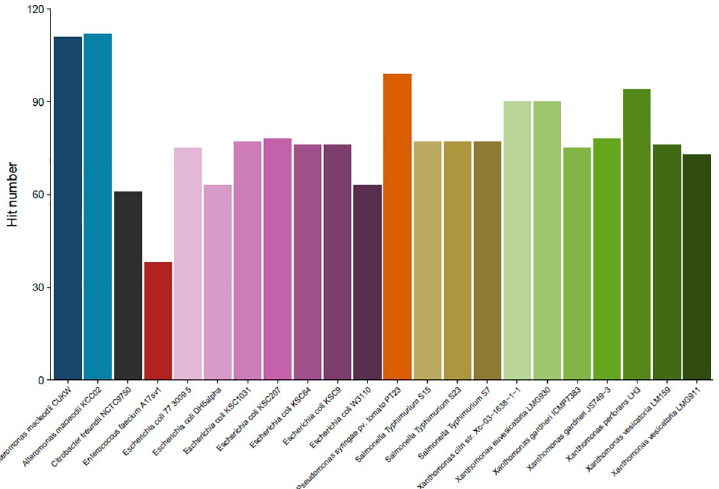
Fig 3. Total number of hits across all systems for copper-associated proteins in CUKW and KCC02 in comparison to bacterial species isolated from copper-rich environments. Model names (Table 7) are shown on the x-axis. An e- value of 1 − 30 served as the threshold for defining a